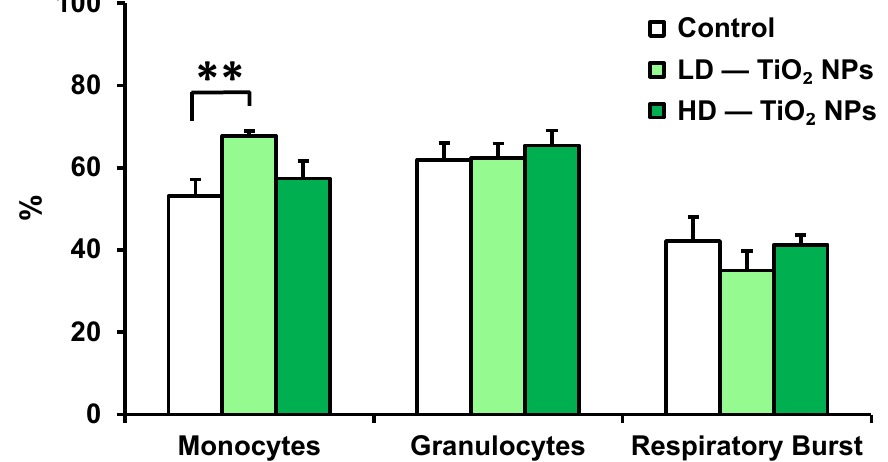
Figure 3. Phagocytic activity and respiratory burst of leukocytes. Phagocytic activity of monocytes and granulocytes in the blood of mice exposed to TiO 2 NPs for seven weeks was evaluated by using ingestion of fluorescein-labeled Staphylococcus aureus , and the respiratory burst was monitored by using hydroethidine by flow cytometry. Control, control group (n = 10); LD–TiO 2 NPs, group exposed to the low dose of TiO 2 NPs (0.012 µg TiO 2 /g b.w. ) (n = 7); HD–TiO 2 NPs, group exposed to the high dose of TiO 2 NPs (0.958 µg TiO 2 /g b.w. ) (n = 10). Results are expressed as the percentage of phagocytic activity and respiratory burst. Bars indicate mean group activity of blood cells (mean + SEM). Significance: ** p < 0.01.